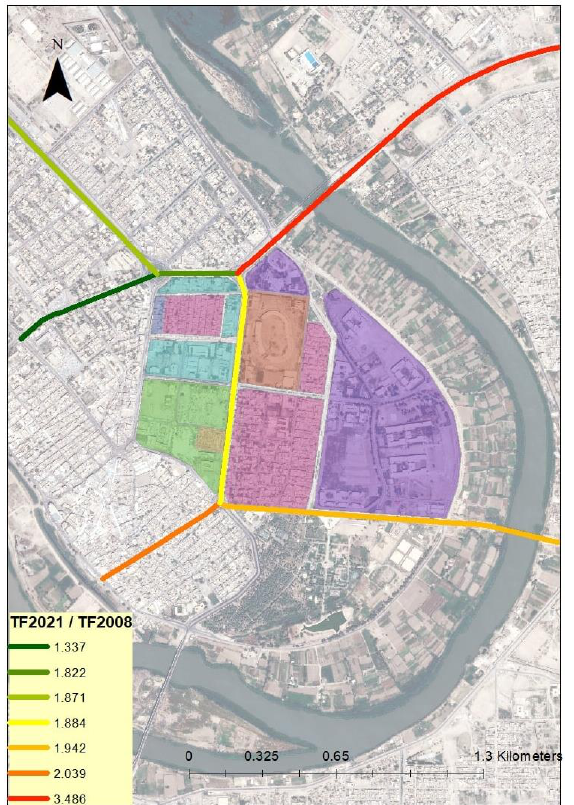
Fig. 10. The percentage of traffic change between 2008 and 2021